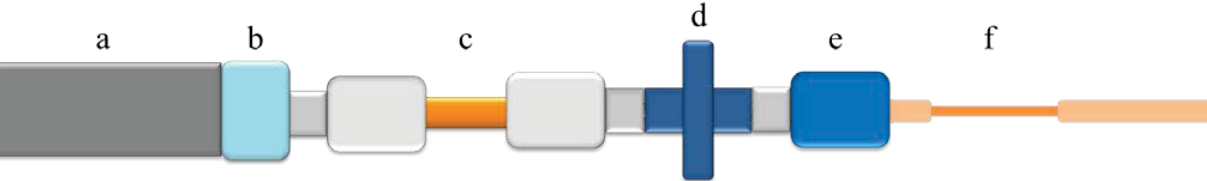
Figure 10. Diagram of the components of an optical light transmission defect: ( a ) laser source; ( b ) collimator; ( c ) fiber cable (NA = 0.27); ( d ) fiber adapter; ( e ) fiber connecter; and ( f ) fiber sensor (NA = 0.37).